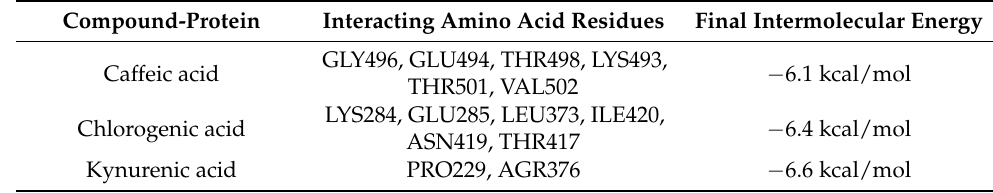
Figure 1. Molecular docking analysis of the ligands caffeic acid, chlorogenic acid, and kynurenic acid with target TOP1. The 3D structure of protein TOP1 bound efficiently with the compound caffeic acid ( A ), chlorogenic acid ( B ), and kynurenic acid ( C ) as shown in their interacting amino acids. Table 1. Molecular docking analysis of the ligands caffeic acid, chlorogenic acid and kynurenic acid with target TOP1.